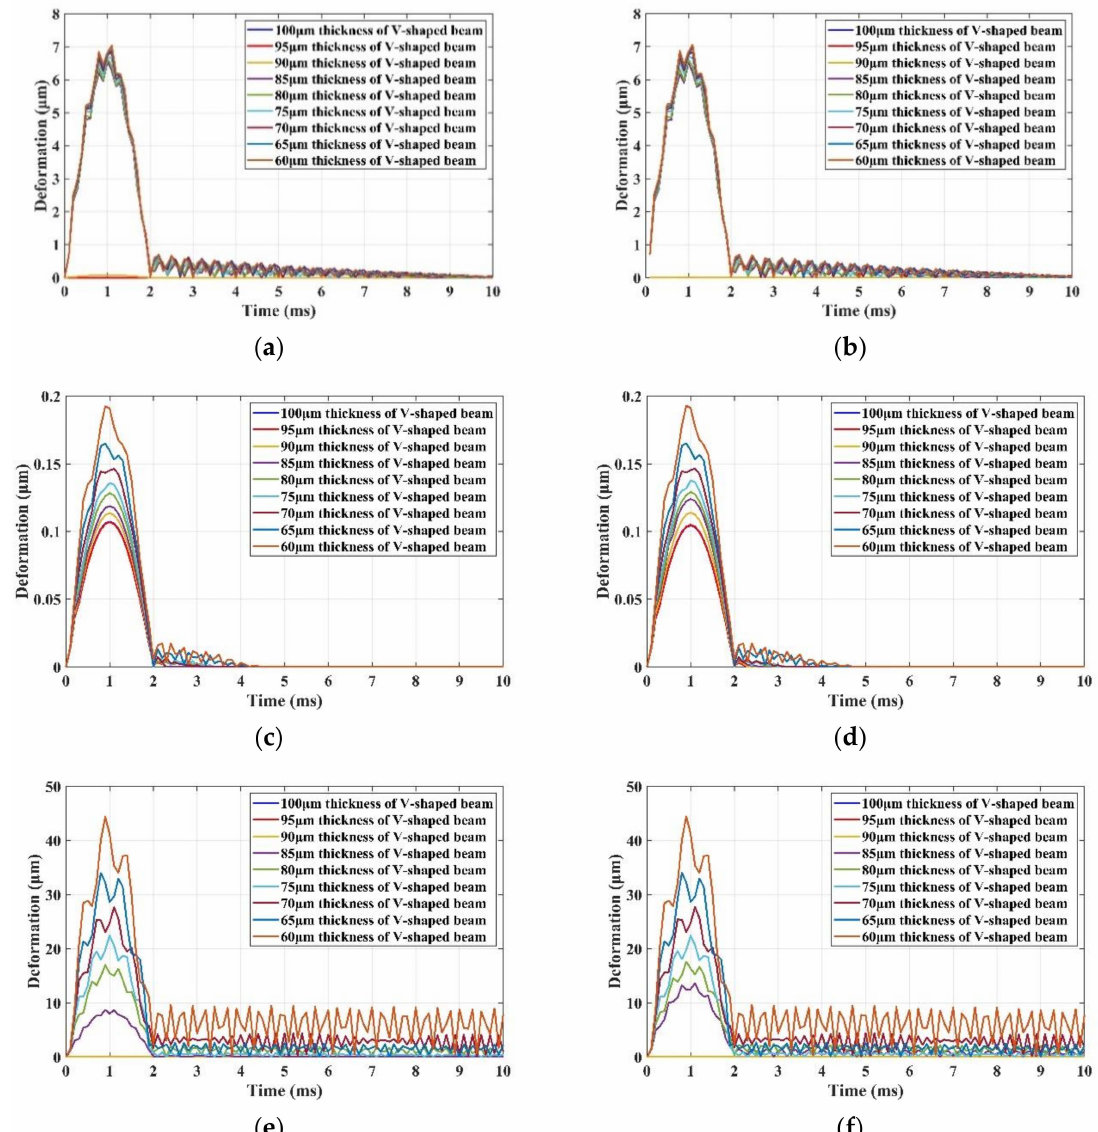
Figure 15. Model of deformation in six shock directions in transient dynamics simulation. ( a , b ) are the deformation in X + and X– direction, respectively. ( c , d ) are the deformation in Y + and Y − direction, respectively. ( e , f ) are the deformation in Z + and Z − direction,